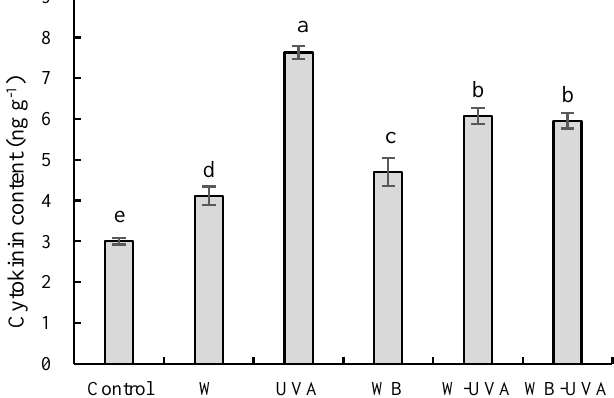
Figure 3. Impacts of supplementary light provided by white (W), UV-A light-emitting diodes (LEDs), and various combinations of W, blue (B), and UV-A LEDs on cytokinin content of green- house-grown cucumber seedlings cultivated for 22 days after sowing; cucumber seedlings grown without supplementary light were used as control. Different letters within each parameter were significantly different tested by the least significant difference (LSD) test at p < 0.05. The supplementary light use efficiency of greenhouse-grown cucumber seedlings was significantly affected by supplementary LEDs (Figure 4). Supplementary white and UVA LEDs led to the lowest and highest supplementary light use efficiency in green- house-grown cucumber seedling production, respectively. In addition, the